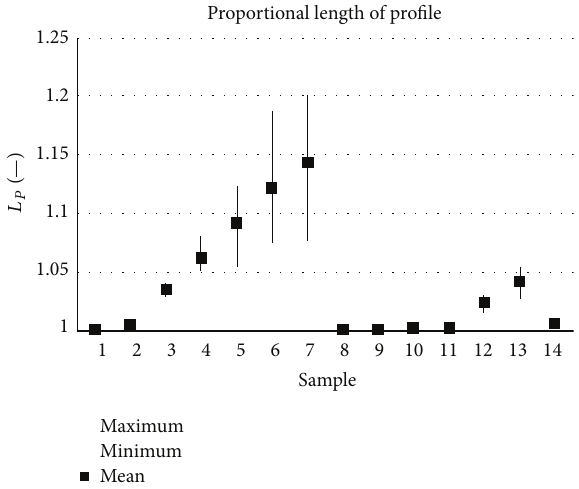
Figure 13: Results of proportional length measurement, 𝐿 𝑃 ( 𝑥 -axis).